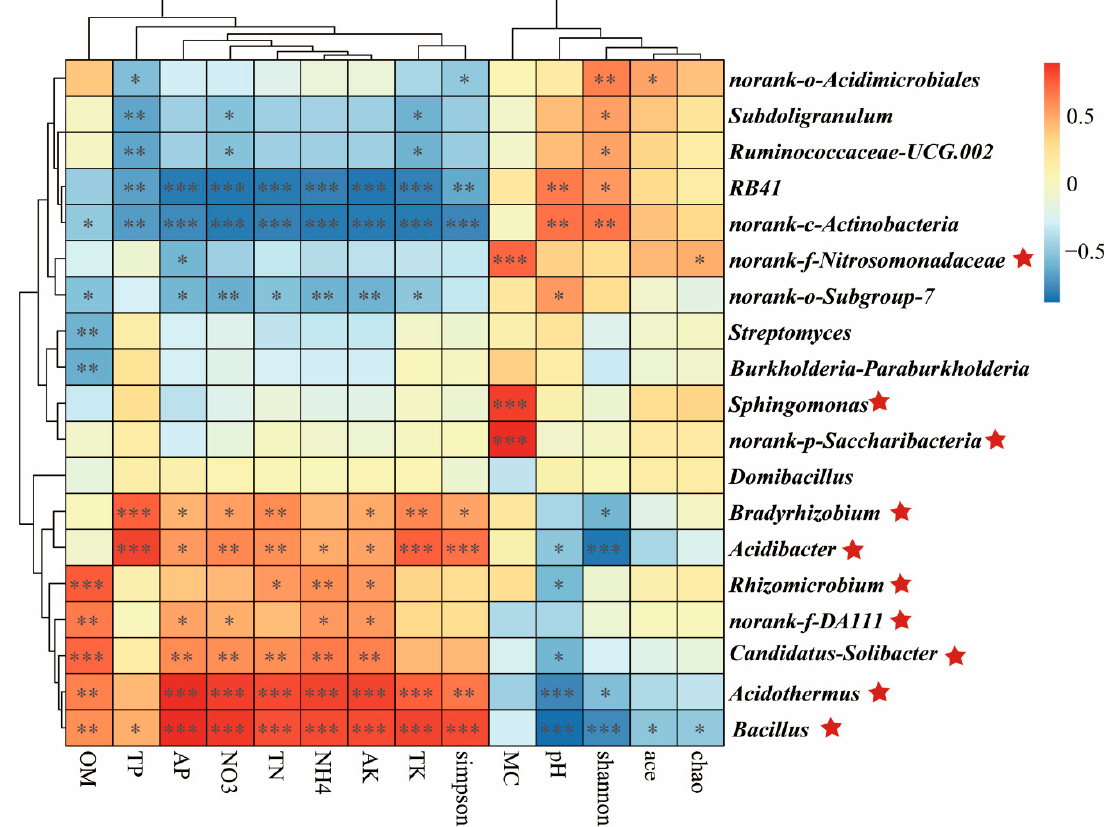
Figure 6. Correlation heatmap of soil microbial community composition and environmental factors (note: * 0.01 < p ≤ 0.05, ** 0.001 < p ≤ 0.01, *** p ≤ 0.001, red star means the bacteria genus is predominant in CK samples).